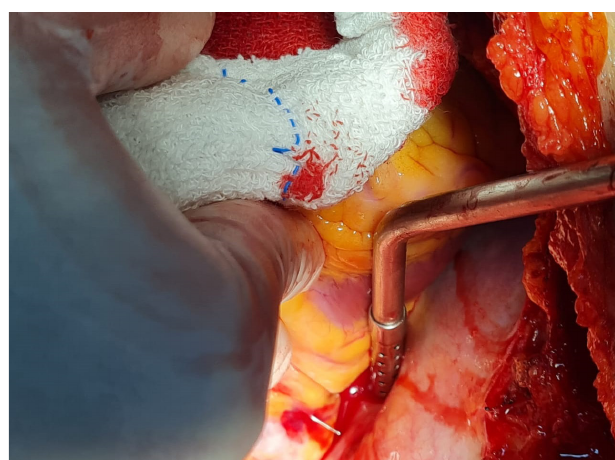
Fig. 2 - Right atrium perforated by inferior vena cava